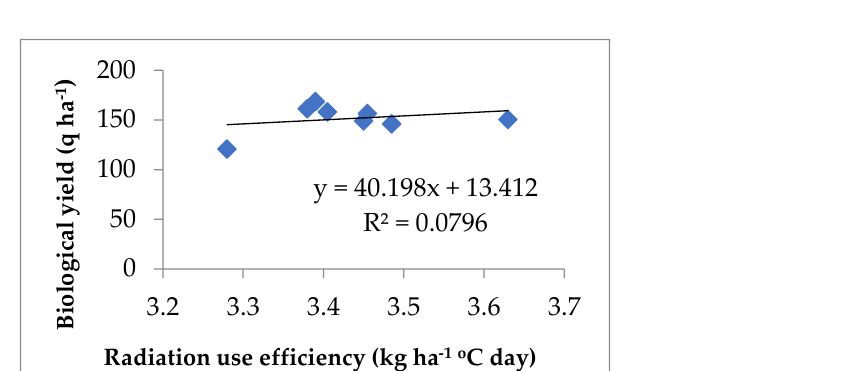
Figure 4. Linear regression equation to find the effect of agrometeorological indices on biological yield of hybrid maize.